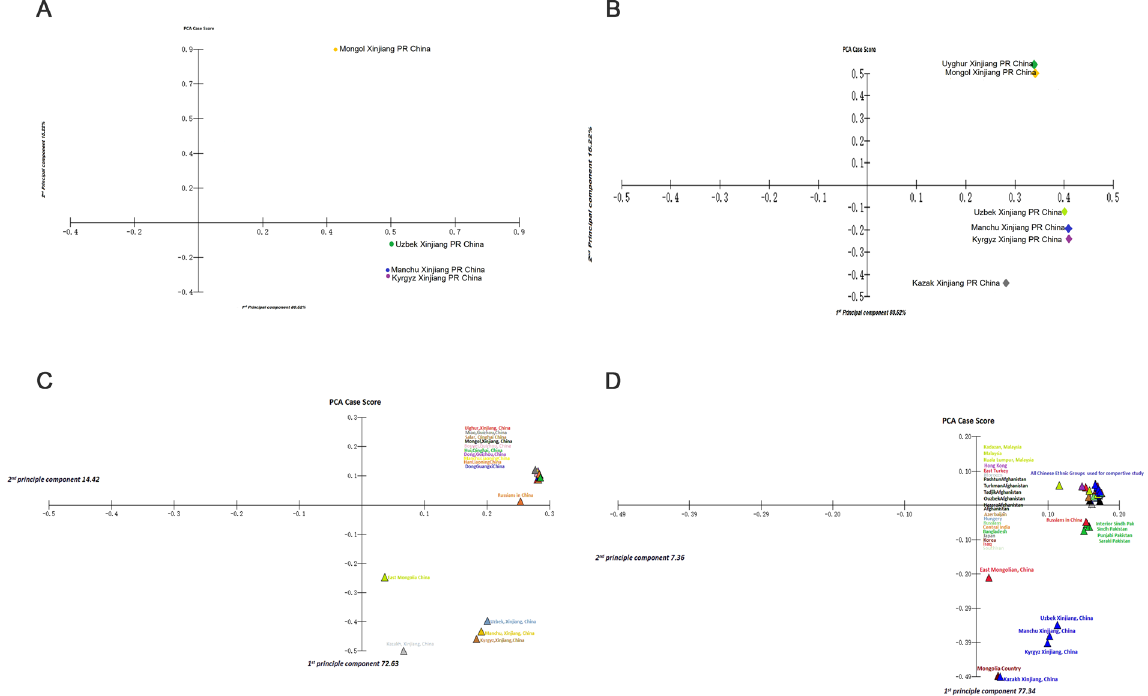
Figure 2. ( A ) Principal component analysis (PCA) based on the 15 autosomal STR loci of the four populations from Xinjiang in this study. ( B ) Principal component analysis (PCA) based on the 15 autosomal STR loci of the four populations from Xinjiang in this study and two other Xinjiang populations from previous studies (Uyghur and Kazakhs). ( C ) Principal component analysis (PCA) based on the 15 autosomal STR loci of the four populations from Xinjiang in this study and other Chinese populations from previous studies. ( D ) Principal component analysis (PCA) based on the 15 autosomal STR loci of the four populations from Xinjiang in this study and other populations from neighboring